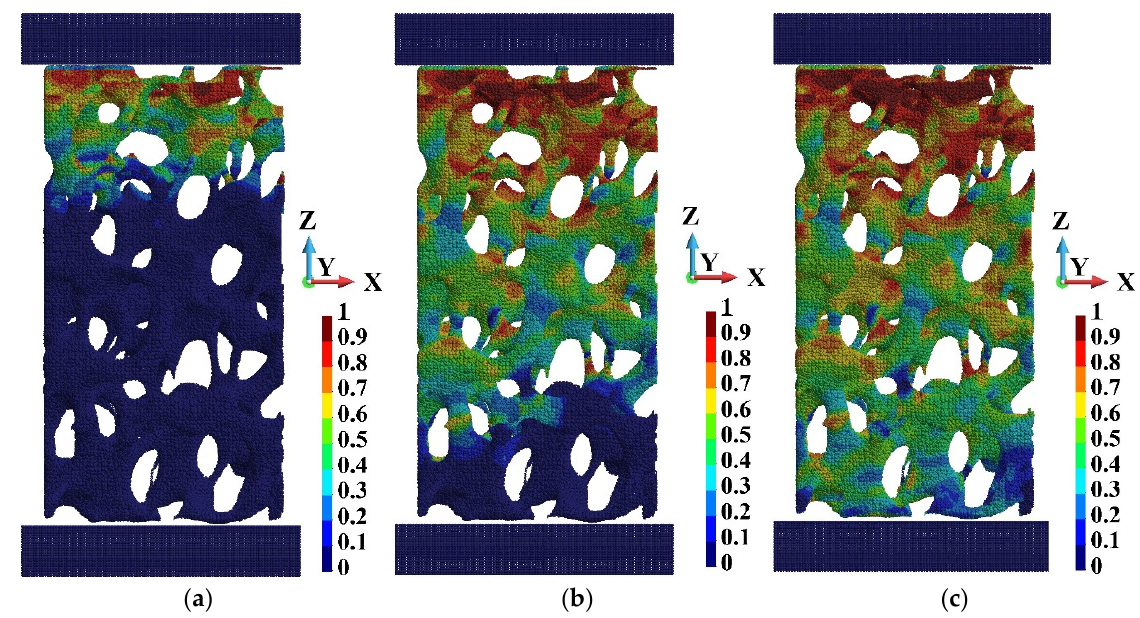
Figure 13. Damage advancement for the piston velocity 40 m/s at time instants: ( a ) 0.6 × 10 − 06 s; ( b ) 0.3 × 10 − 05 s; ( c ) 0.42 × 10 − 05 s.